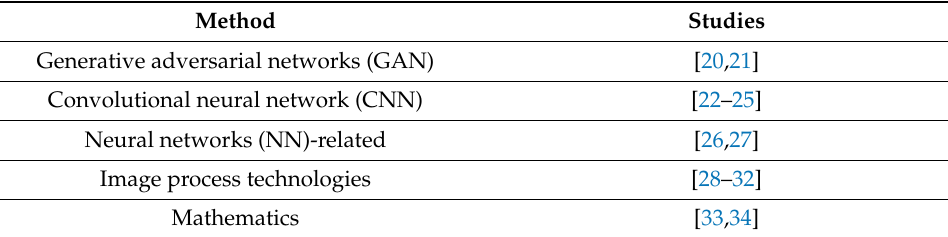
Table 2. The main anomaly detection approaches from 2017 to 2022 that used